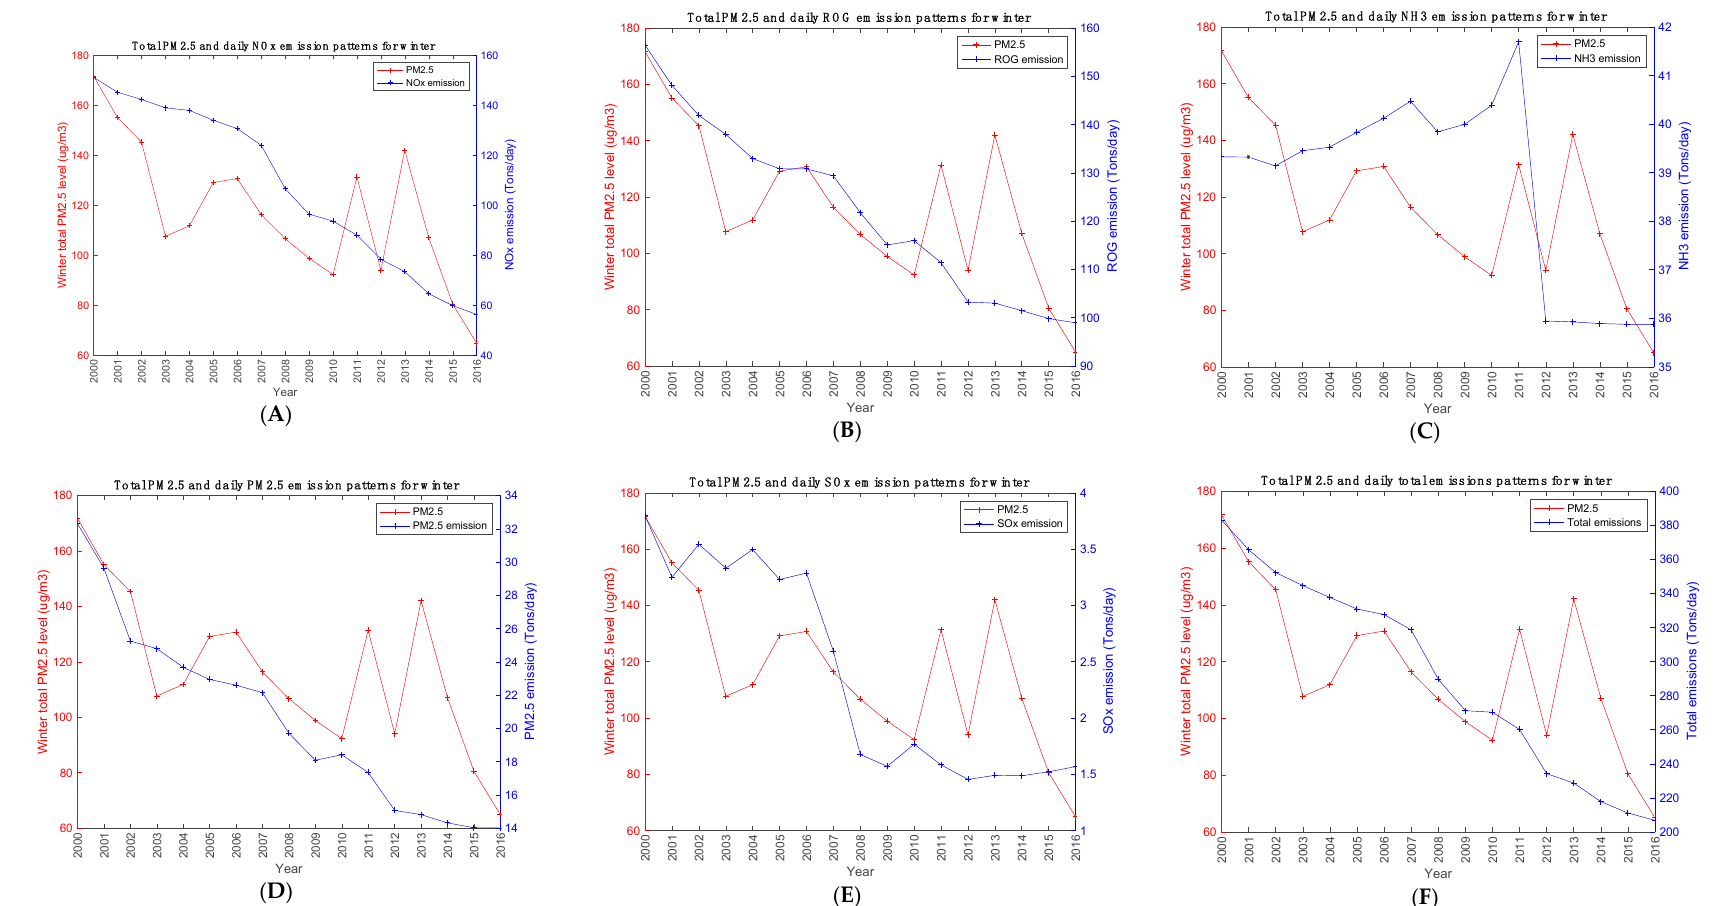
Figure 9. Long-term time series of atmospheric PM 2.5 level with NO x ( A ), ROGs ( B ), NH 3 ( C ), * primary PM 2.5 ( D ), SO x ( E ) emissions and total of NO x , ROGs, NH 3 , primary PM 2.5 and SO x emissions (F). * Primary PM 2.5 emissions are PM 2.5 emitted directly to the atmosphere.